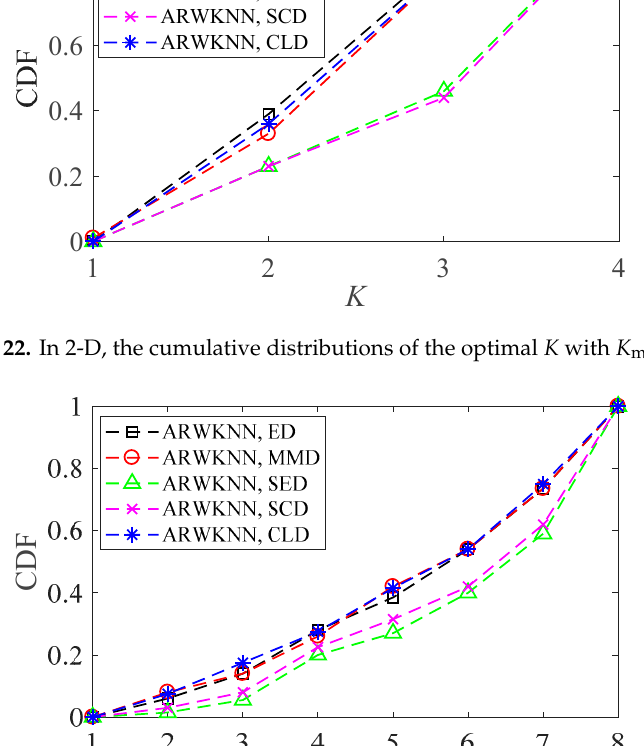
Figure 23. In 3-D, the cumulative distributions of the optimal K with K max = 8.